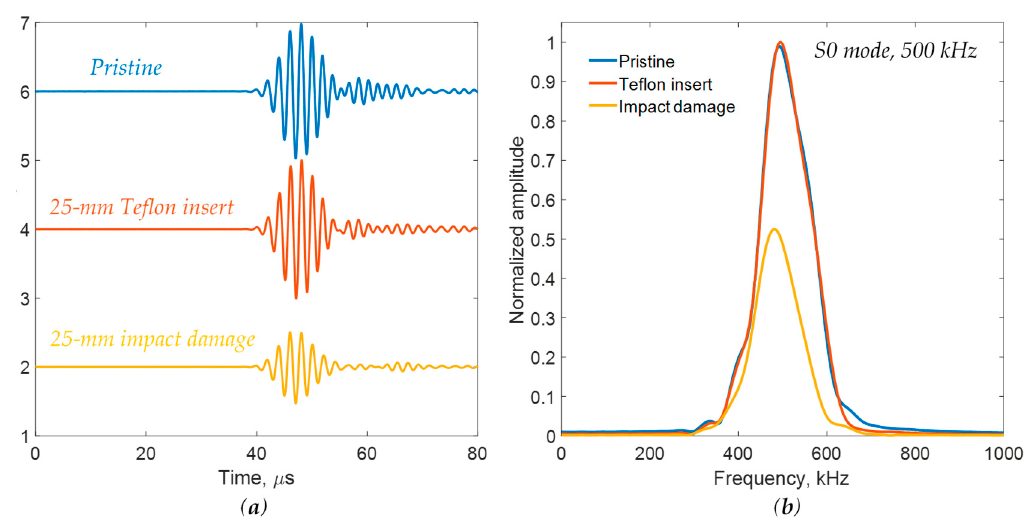
Figure 13. Signal comparison between the pristine area, the Teflon insert, and the impact damage using pure S0 mode at 500 kHz in 2-mm quasi-isotropic composite plate: ( a ) time-domain signals; ( b ) frequency spectrums.